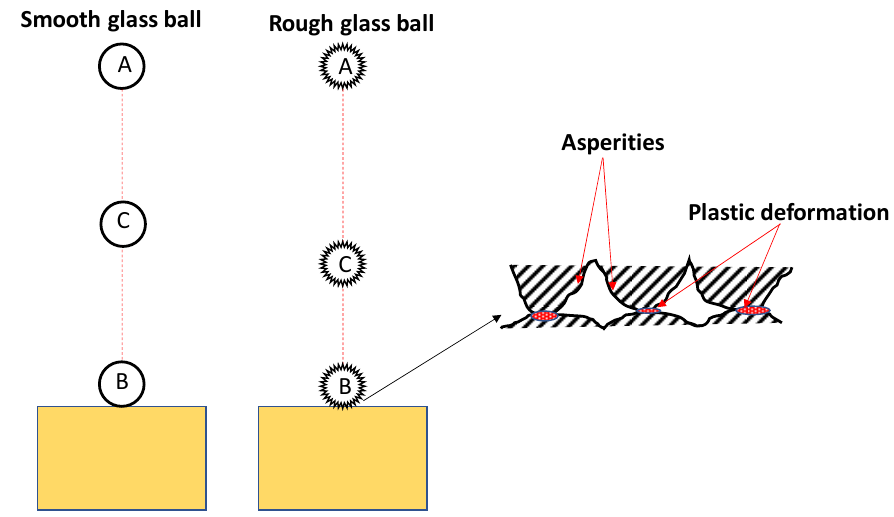
Figure 8. A schematic representation of smooth and rough glass ball impacts on base block (A) initial position (B) during impact (C) position after